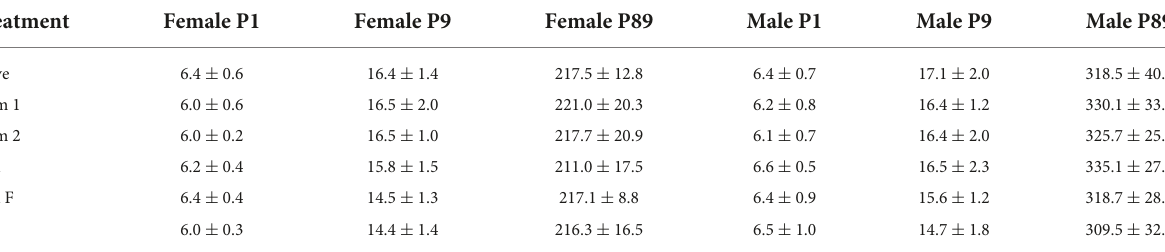
TABLE 1 Body mass (in grams) of male and female rats over the course of the study on P1, P9, and P89, according to the experimental groups. Treatment Female P1 Female